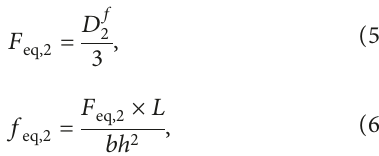
Figure 6: Calculation of DBV-1998 standard flexural toughness.